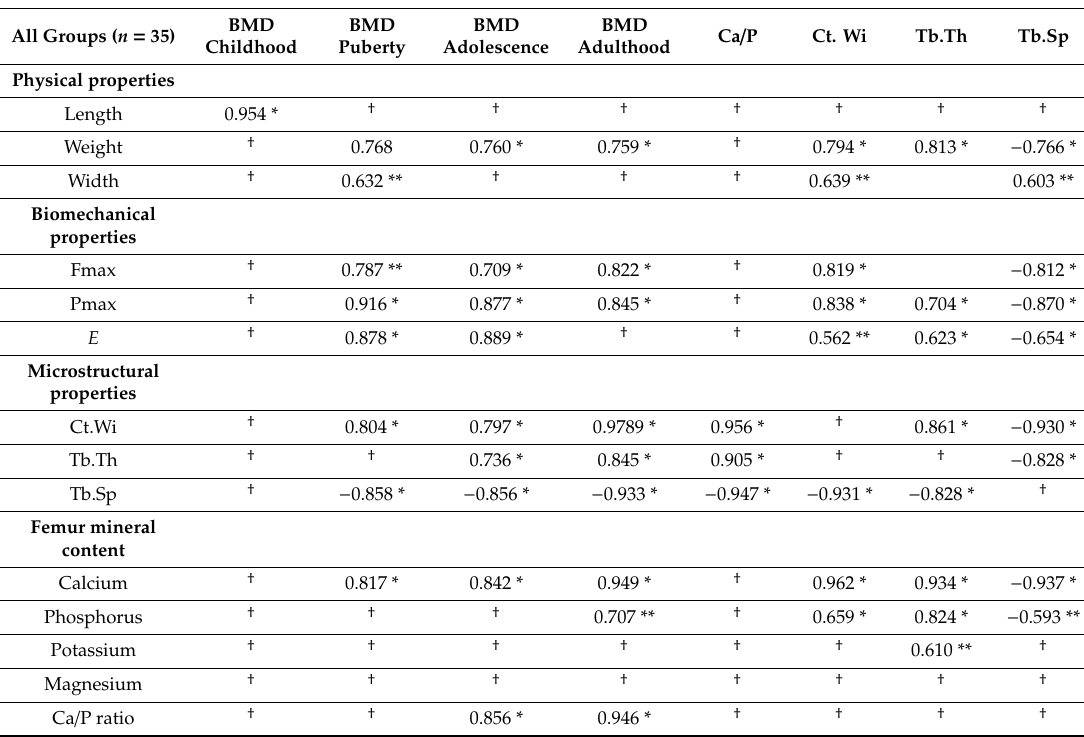
Table 6. Correlation coe ffi cients between the BMD, mechanical, microstructural properties, and mineral content of the femurs in the experimental